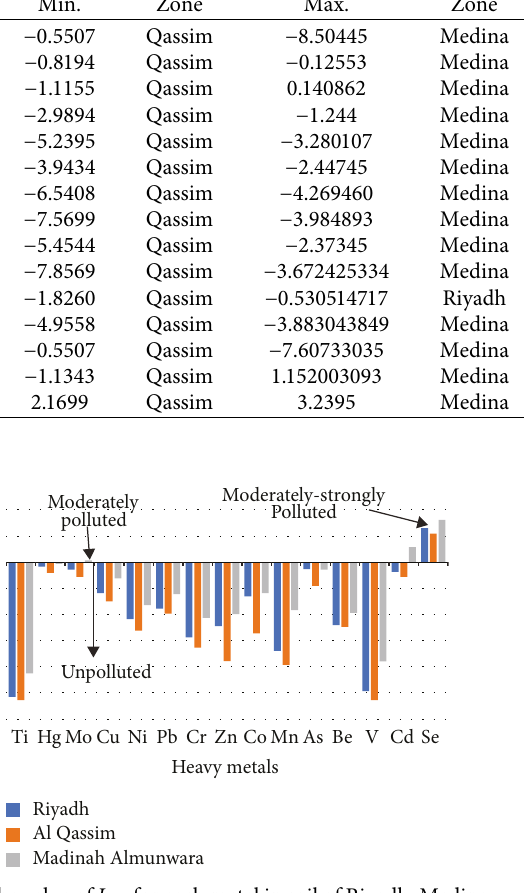
Table 6: Results of geographical accumulation index ( I Element Min.